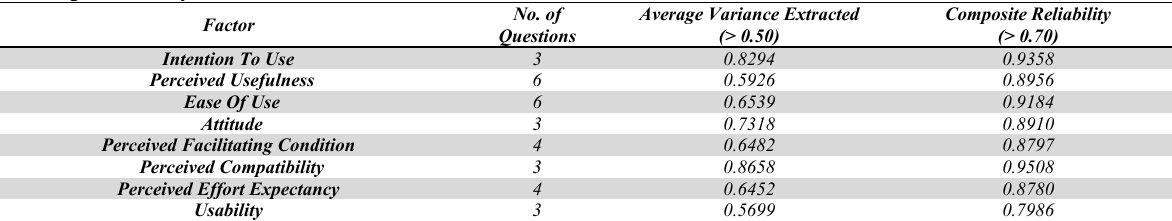
Convergent Validity